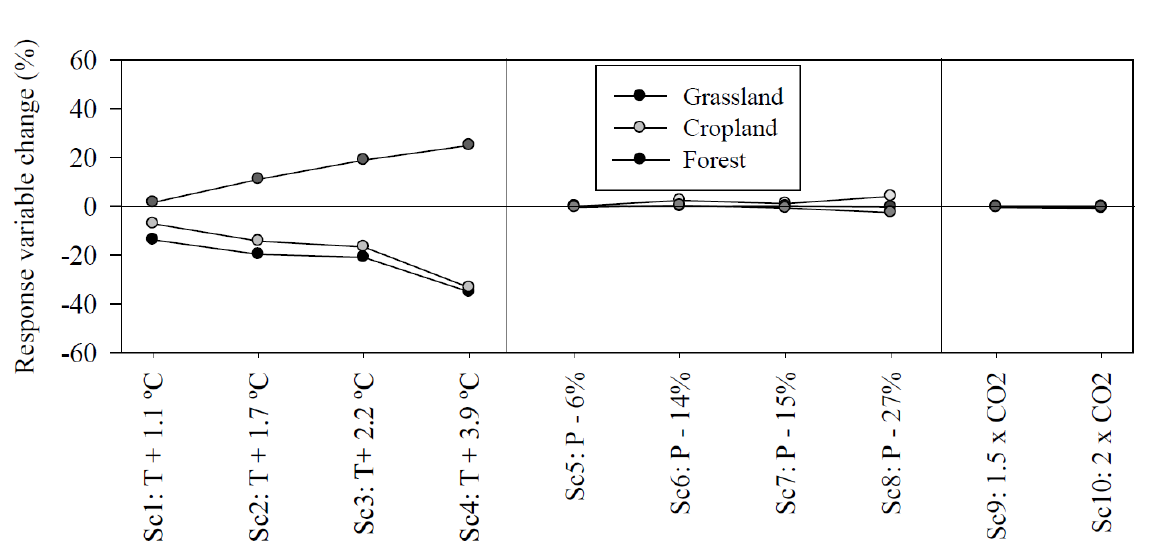
Figure 5. Response of vegetation biomass to changes in temperature, rainfall and CO 2 concentration based on the scenarios defined in Table